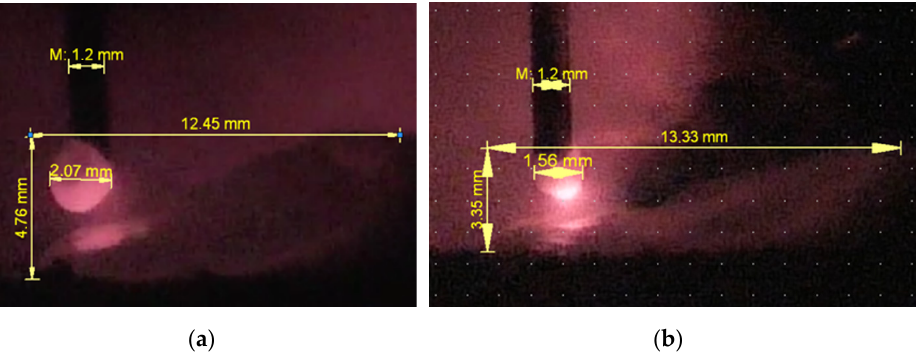
Figure 4. Dimensions of the droplet and the welding pool: ( a )—straight polarity; ( b )—reversed. The surface tension decreases almost linearly with the temperature, vanishing at the critical temperature, which is confirmed by the Eötvös Equation (2):